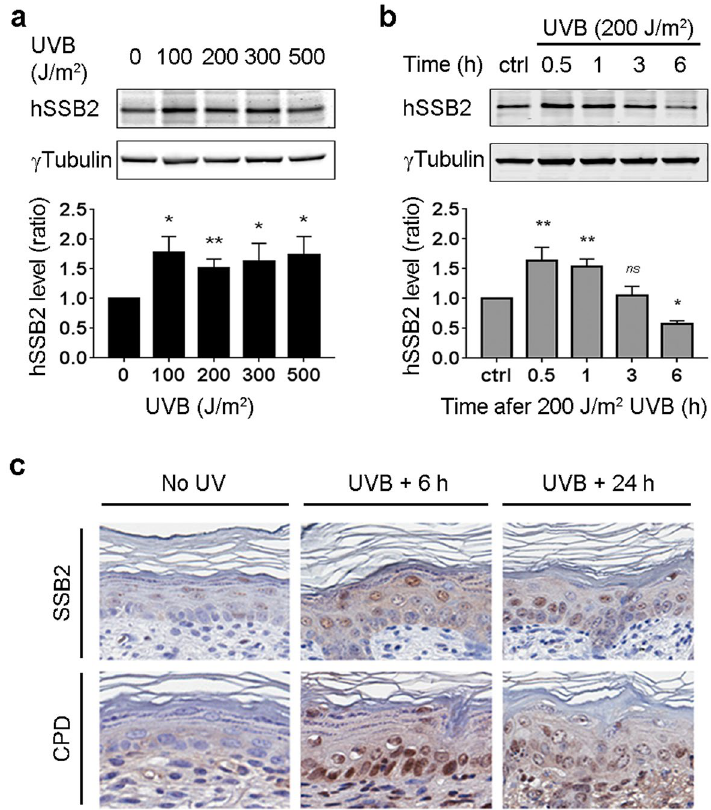
Figure 1. hSSB2 level increases after UVB exposure. ( a , b ) Representative western blot for hSSB2 and γ Tubulin for HeLa cells protein extracts 1 h after increasing doses of UVB ( a ) and at increasing repair time (h) after 200 J/ m 2 UVB ( b ). Average hSSB2 levels (± sem) over 3 independent experiments have been reported in the graphs below the blots ( ns : non-significant; *P-value < 0.05; **P-value < 0.01; ***P-value < 0.001 in a One-Way ANOVA). ( c ) Immuno-histo chemistry staining (brown staining) for SSB2 (top panels) and DNA UV damage (CPD, bottom panels) of skin sections from 3 days old C57BL/6 mice not exposed to UV (left panels), 6 h (middle panels) and 24 h (right panels) post UVB